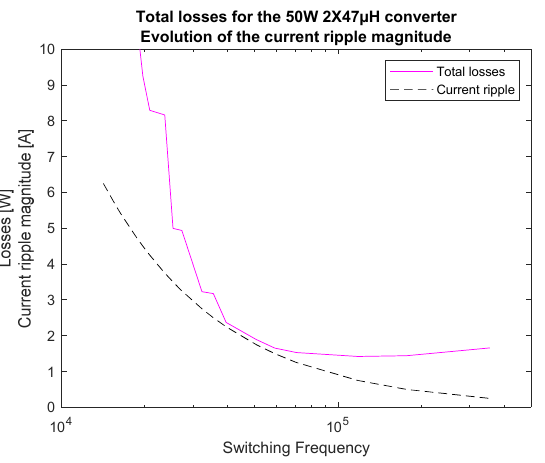
Figure 18. Calculated total losses into the full-bridge converter considering all losses modelled in Section 3. These losses are considered for a 30 V to 20 V, 50 W converter equipped with 2 × 47 µH main inductors.